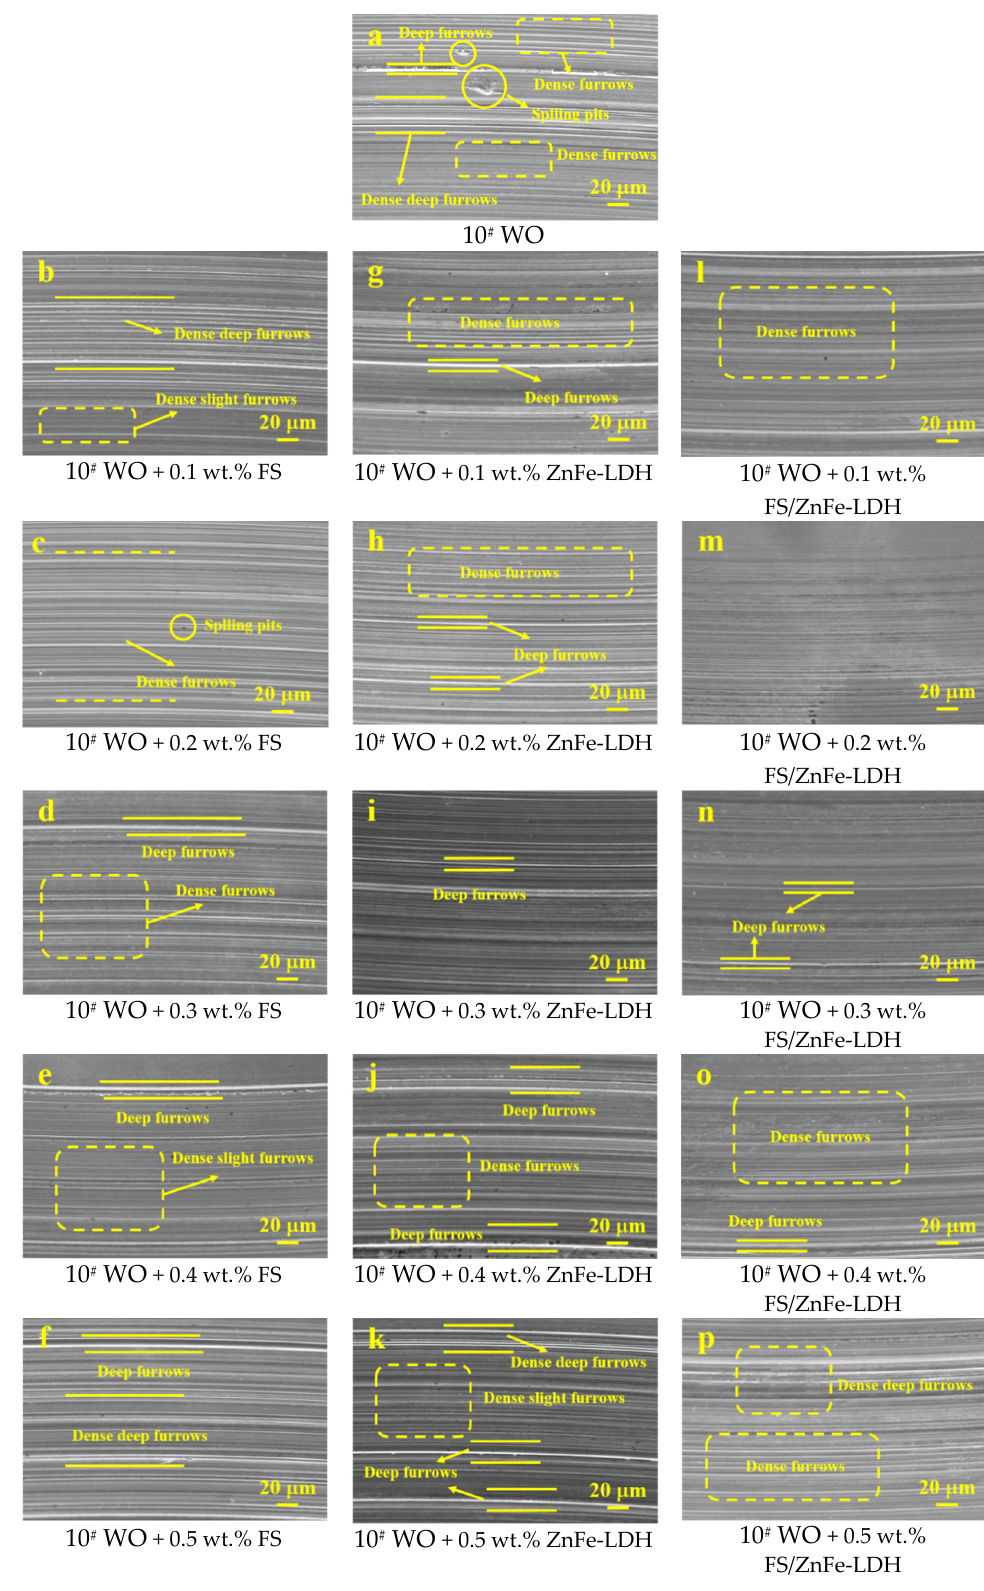
Figure 9. SEM diagram of ball wear scars.